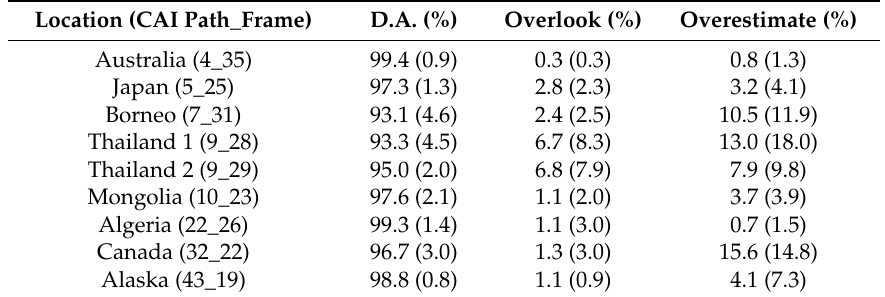
Table 4. Average and standard deviation (in parentheses) of degree of agreement (D.A.), Overlook, and Overestimate for each study